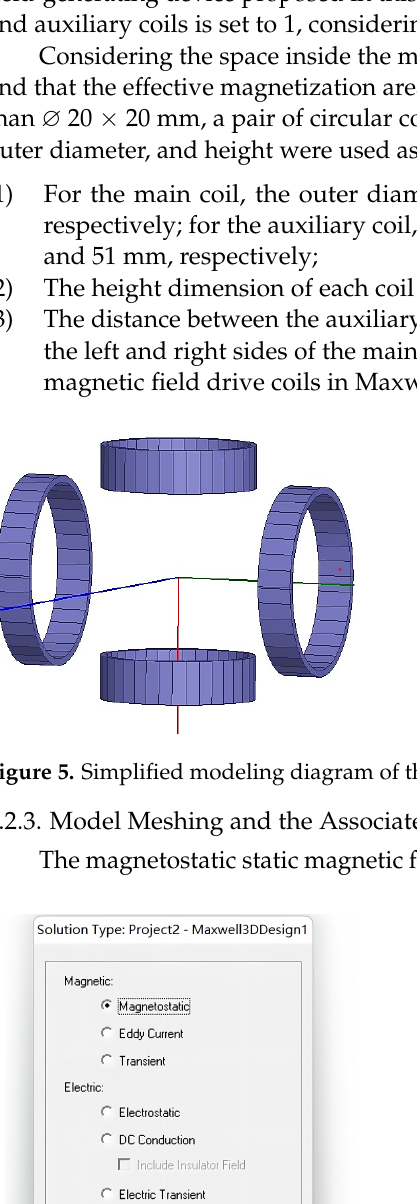
Figure 7. Mesh division diagram of the magnetic field generator. After the grid division is completed, the calculation area is created, the excitation source is set, the material is set, etc. The settings of the relevant simulation parameters are shown in Table 2. Table 2. Simulation Parameters of the static magnetic field. Parameter Setting Region 100% Material Upper and lower fixed plate, coil fixed column, profile: aluminum Coil: copper Driving Source Current source: Ann turns, direction: Negative Analysis Setup